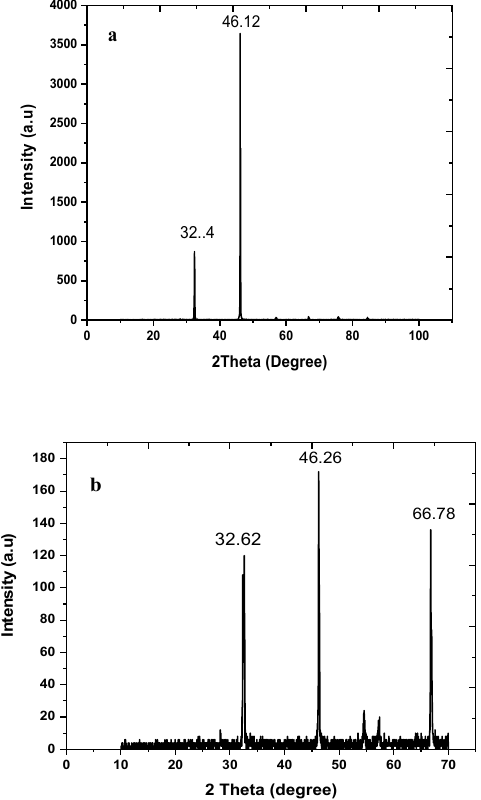
Figure 7. X-ray diffraction spectroscopy (XRD) for ( a ) CDs-EDA ( b ) CDs-L-Ph.